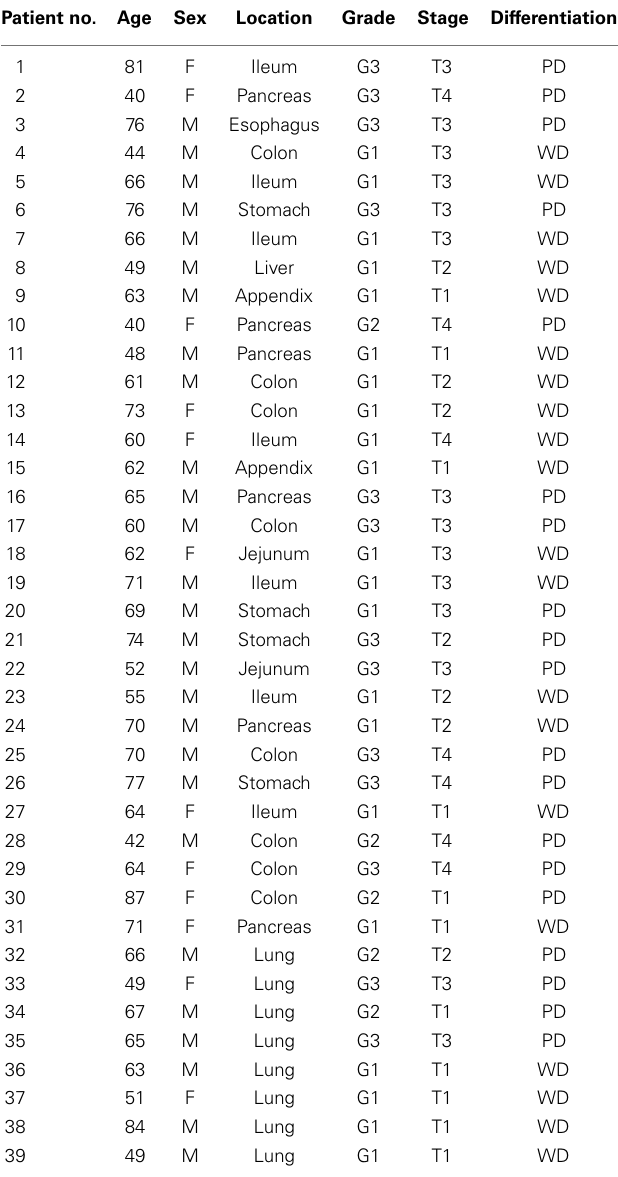
Table 1 | Patient demographics, histologic grade, and staging